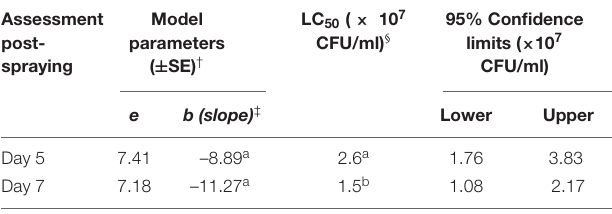
TABLE 4 | Modeling concentration-mortality relationship and estimation of median lethal concentration (LC 50 ) at different exposure times after spraying C. rosea (strain CMAA1284) submerged conidia onto early whitefly nymphs (from first to second instars) on bean leaves. Assessment